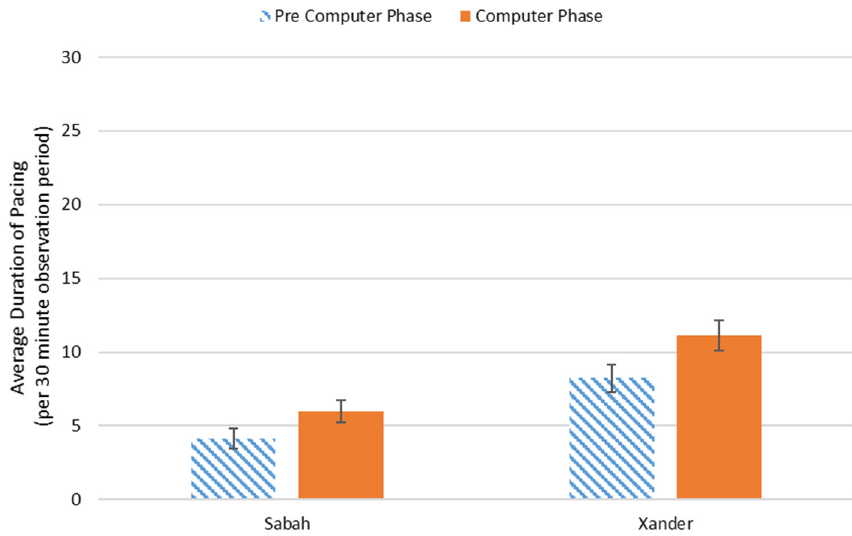
Figure 2. Average amount of time spent pacing before and after the introduction of the touchscreen computer (bars indicate standard error). Xander showed a significant difference across conditions at the p < 0.05 level.